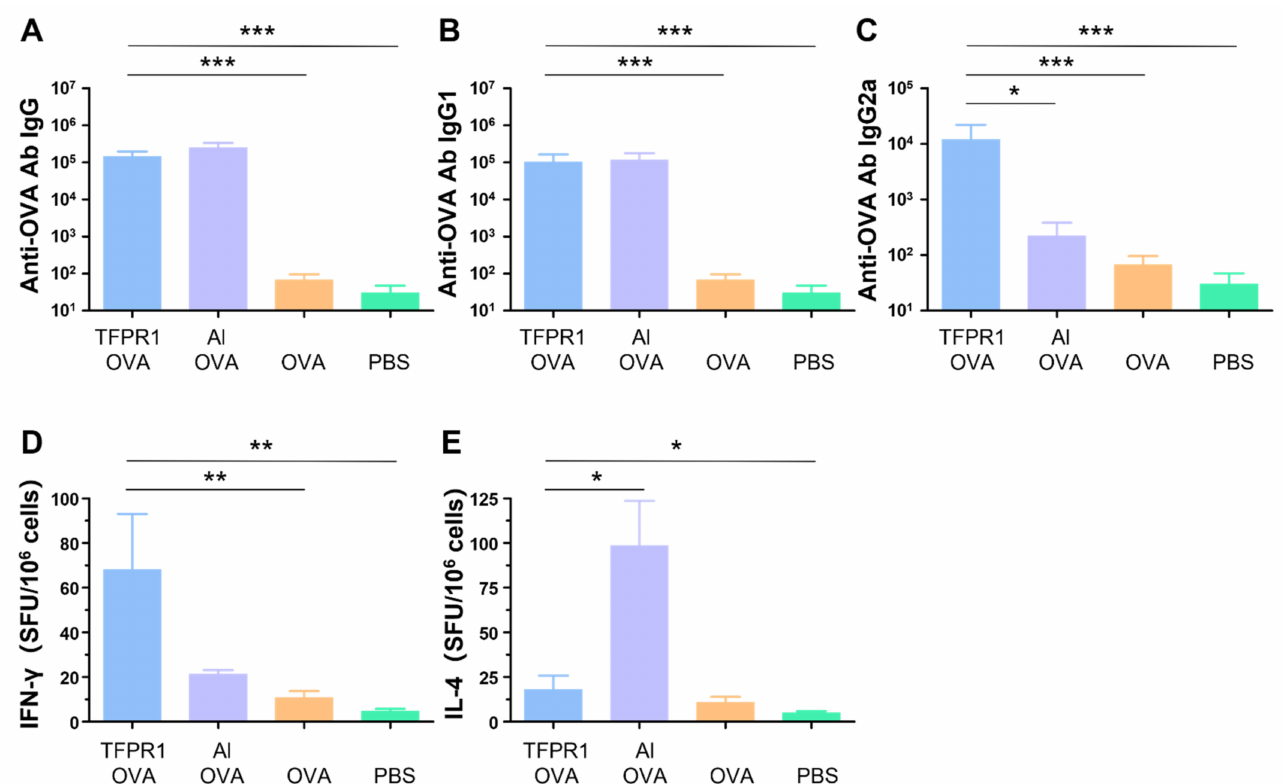
Figure 1. Anti-OVA antibodies and cellular immune responses in C57BL/6 mice immunized with TFPR1 and OVA. C57BL/6 mice were immunized thrice with TFPR1 and OVA, alum and OVA, OVA alone or PBS intramuscularly. On the second week after the final immunization, anti-OVA antibodies were detected by ELISA and cellular immune responses were measured by ELISPOT. ( A ) Anti-OVA antibody IgG. ( B ) Anti-OVA antibody IgG1. ( C ) Anti-OVA antibody IgG2a. ( D ) Specific IFN- γ . ( E ) Specific IL-4. Note: * stands for p < 0.05, ** p < 0.01, and *** p <